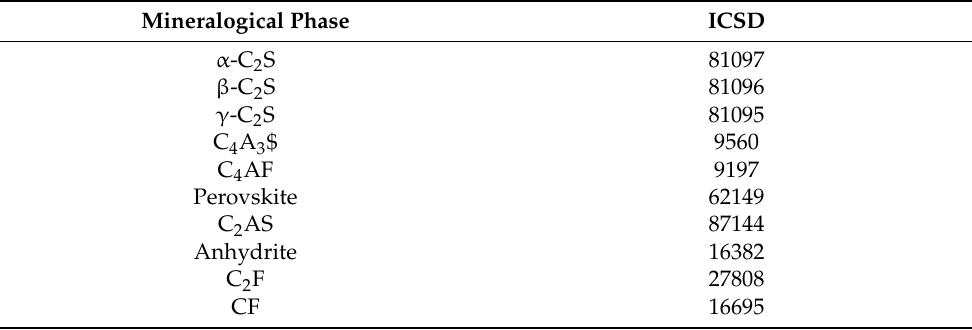
Table 4. ICSD of the main minerals in BBSC clinker and its hydration products in this